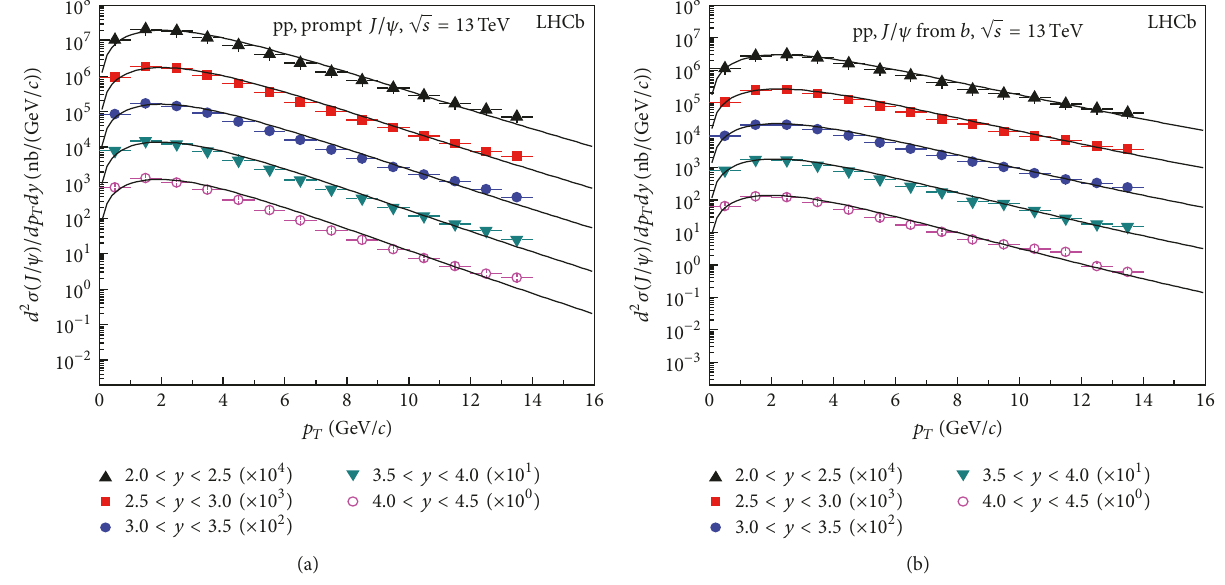
Figure 4: Same as Figure 2, but for √𝑠 NN = 13 TeV. The experimental data are taken from the LHCb Collaboration [26].